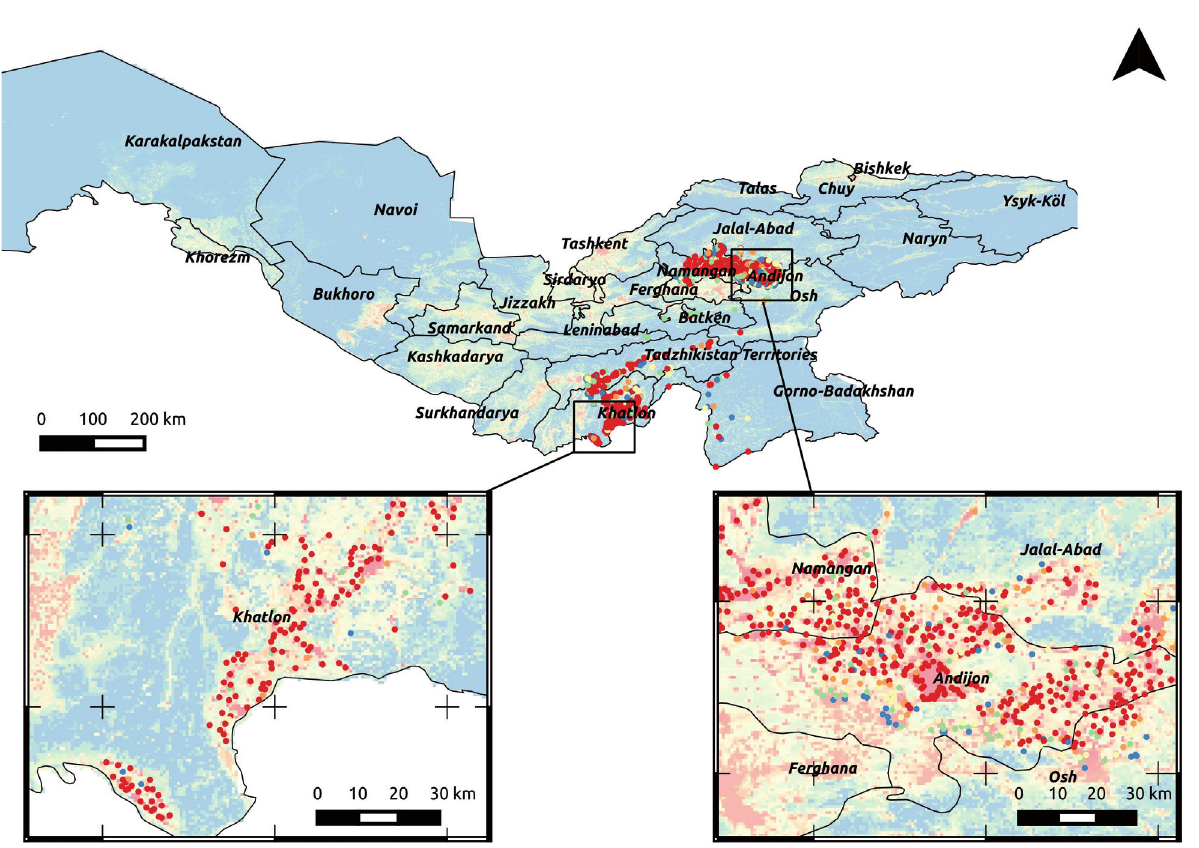
Figure 12. Sampling of settlements in the region of interest for further risk assessment. The focus map is used to rank all populated places in the region. Only the settlements with sampling probability greater than 0.9 (for each of the three considered countries) are